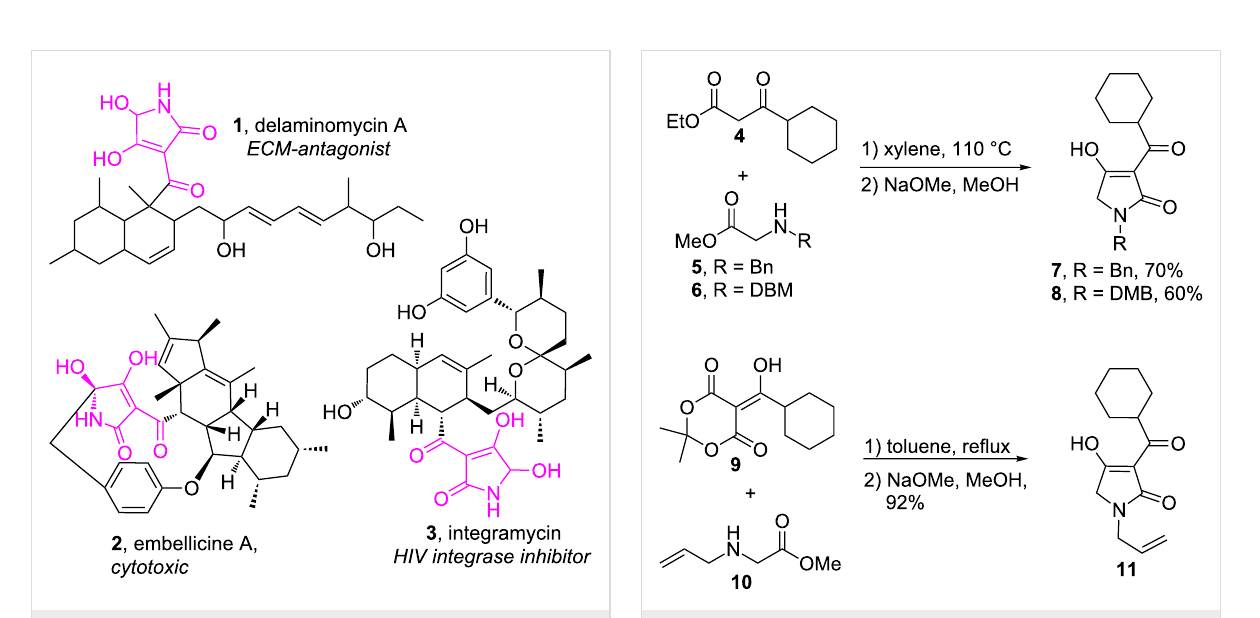
Figure 1: Naturally occurring 5-hydroxylated 3-acyltetramic acids.